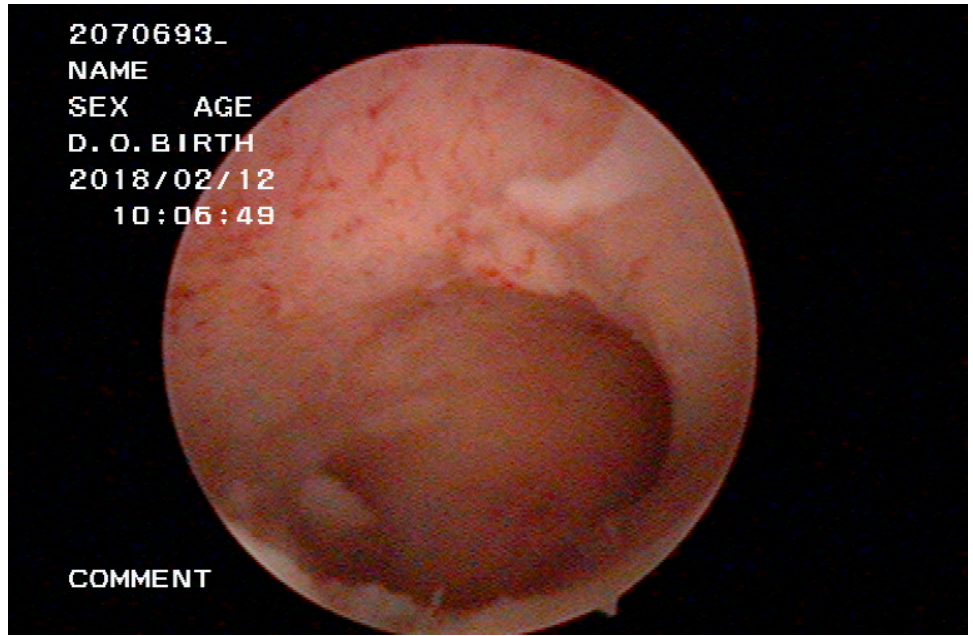
Figure 1. Hysteroscopic view of a dysmorphic uterus.